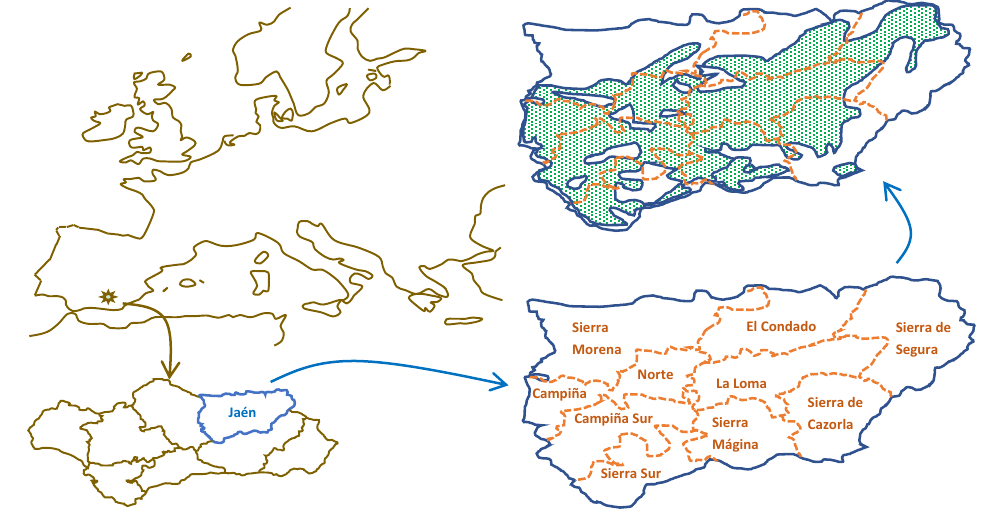
Figure 1. Olive cultivation areas by agricultural region in Jaén (Spain).